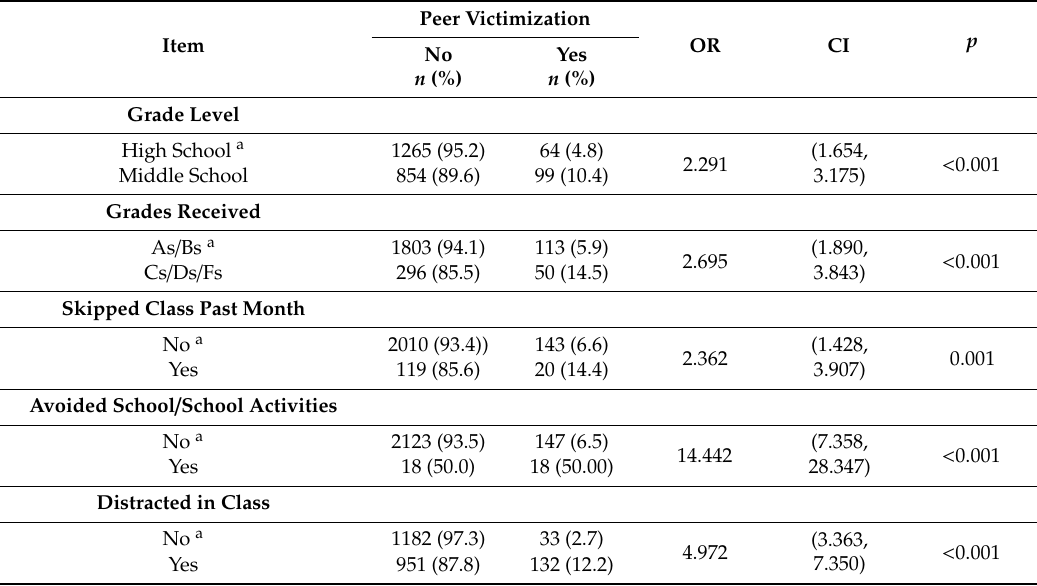
Table 1. Individual Factors and Peer Victimization.